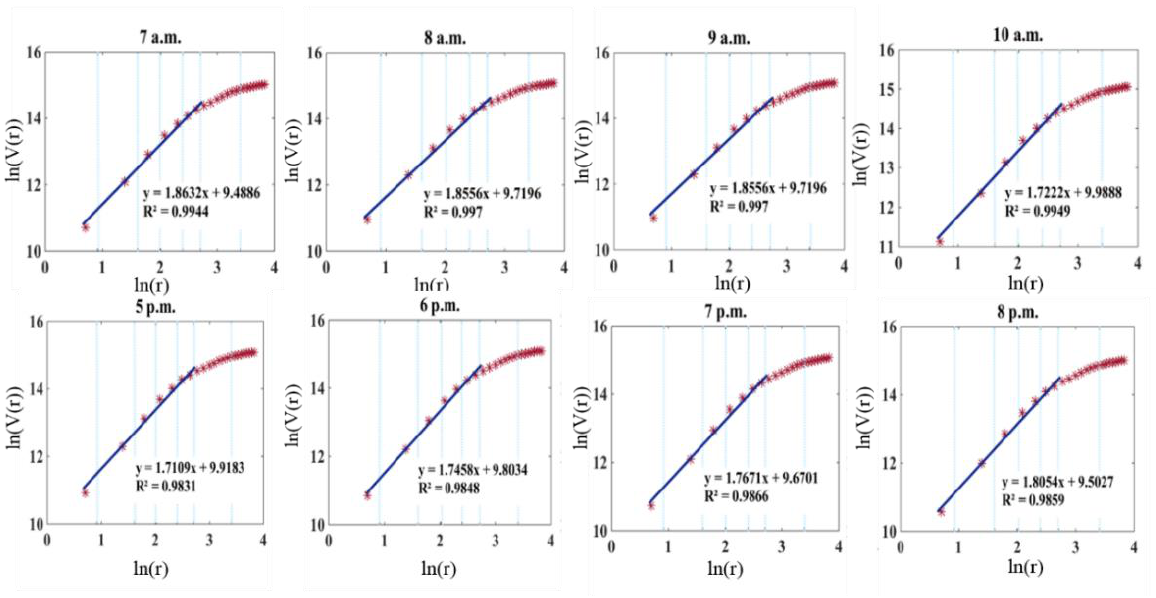
Figure 12. Volume dimension of population distribution deprived from mobile phone data.